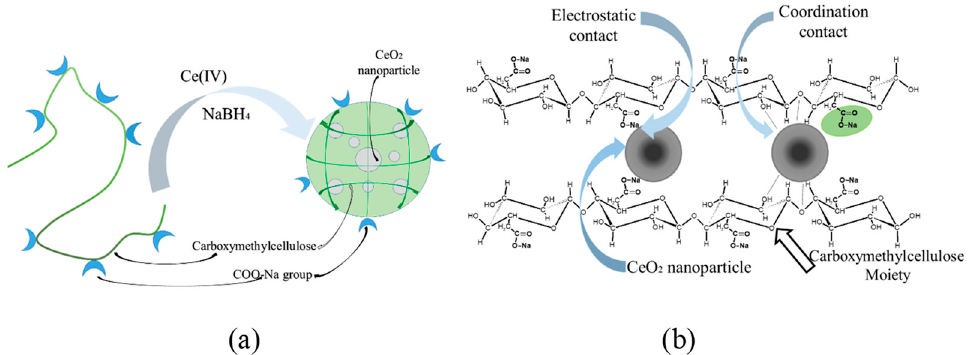
Figure 8. Scheme of formation of the CMC–CeO 2 composite ( a ); Electrostatic and coordination bond formation between polysaccharide and surface of cerium oxide nanoparticles ( b ). formation between polysaccharide and surface of cerium oxide nanoparticles ( b